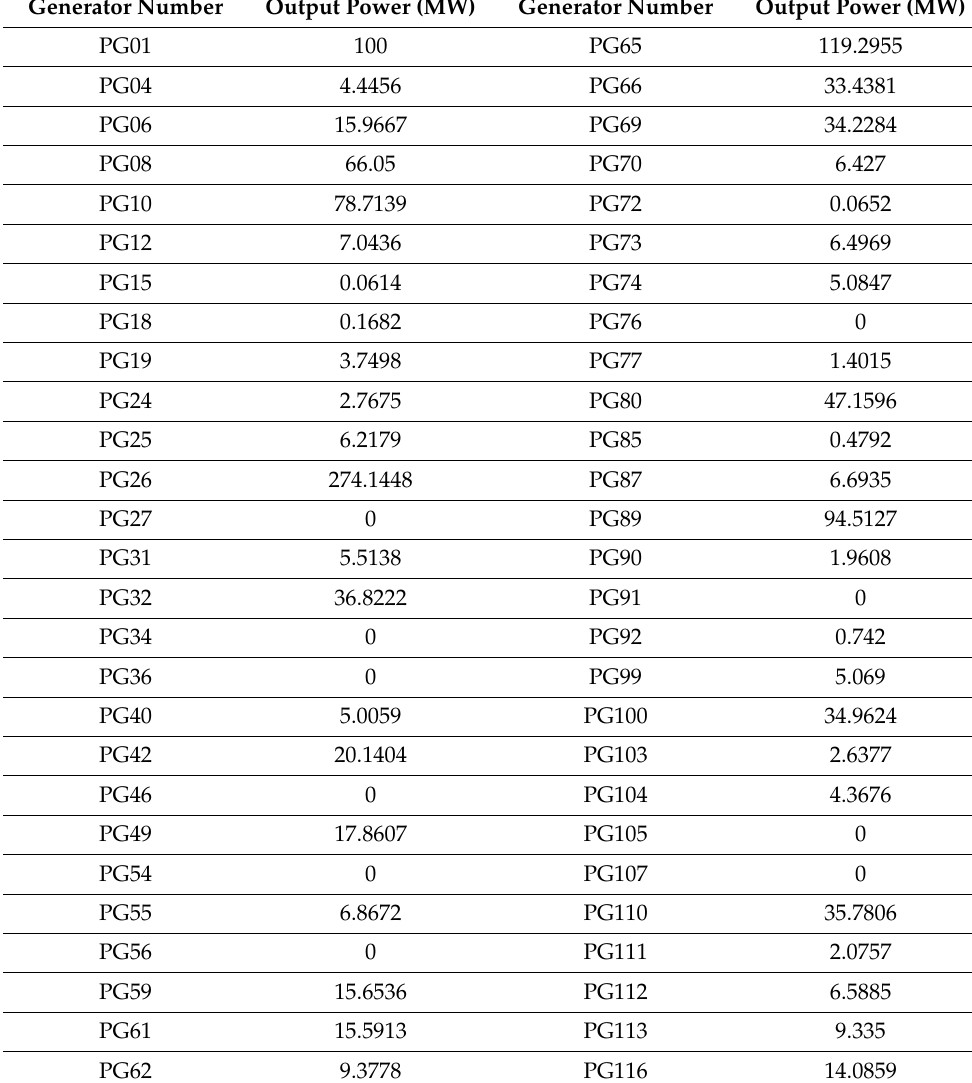
Figure 9. Convergence curve for IEEE-118 bus system using AO. Table 4. Generator power for IEEE-118 bus system.